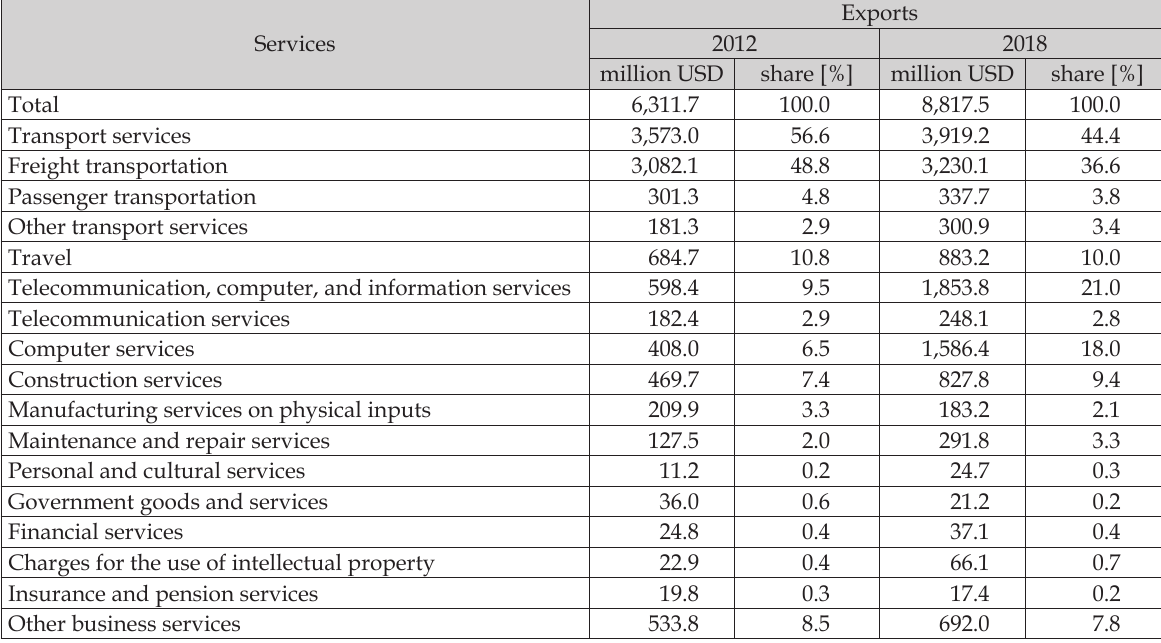
Table 4. Structure of service exports of the Republic of